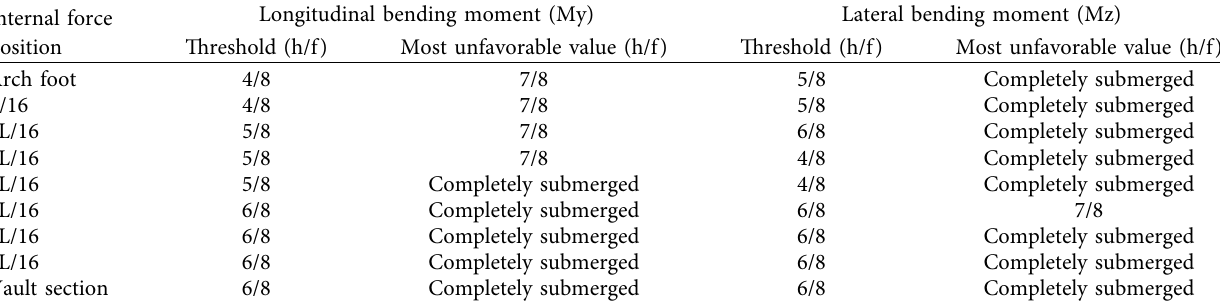
Table 11: Te threshold and most unfavorable value of the submerged